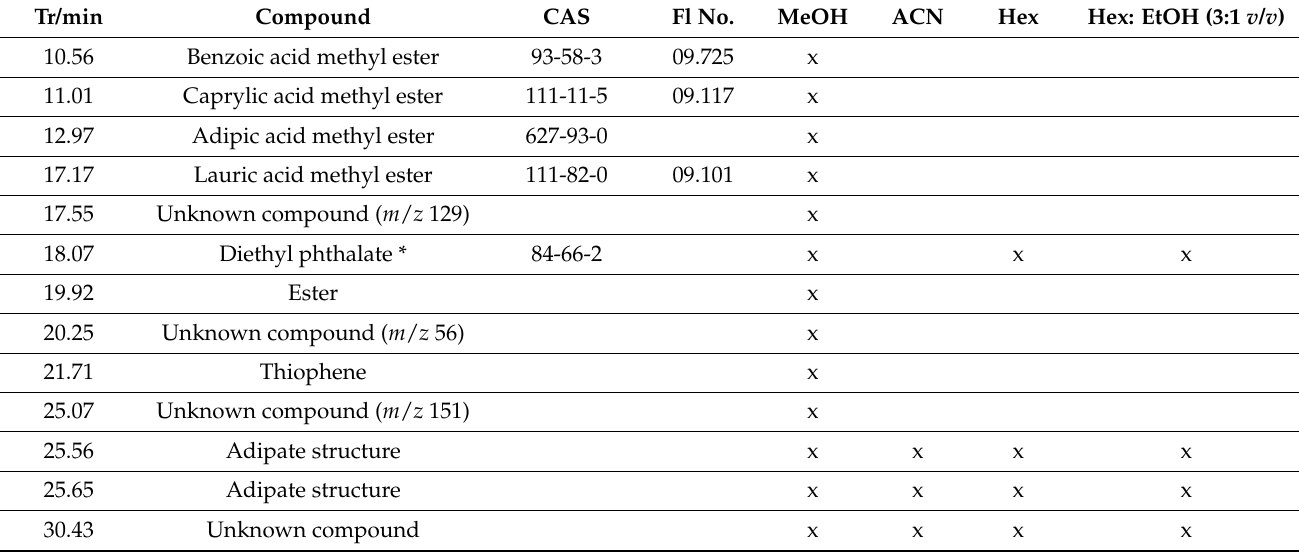
Table 2. Comparison of the most abundant detected compounds in sample BC04 using different extraction solvents.